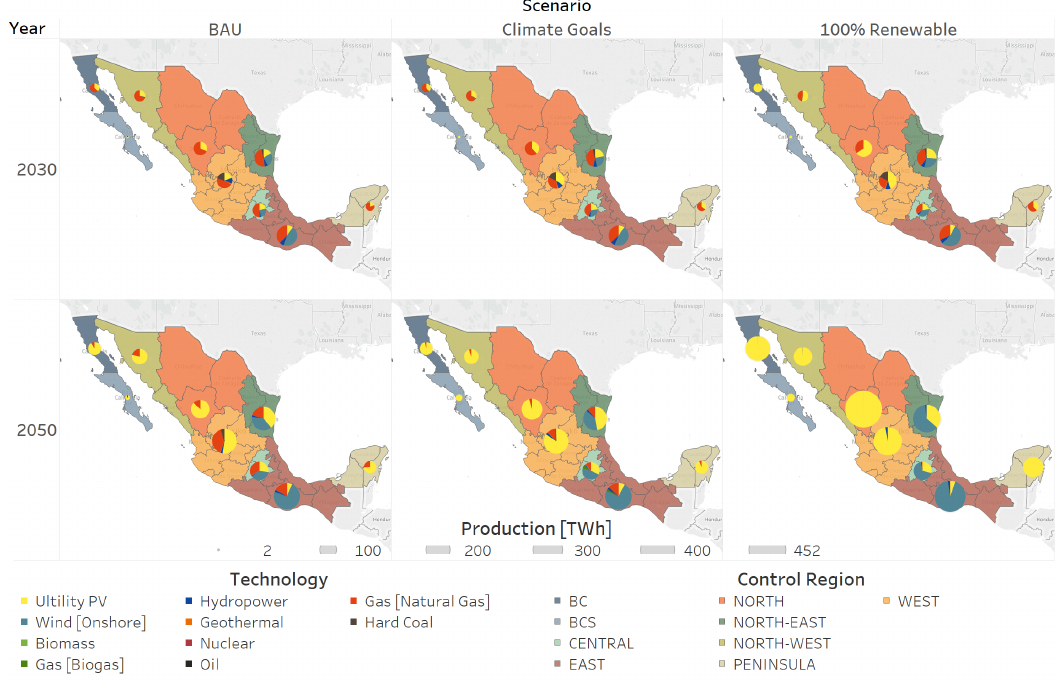
Figure 8. Regional generation of electricity in the years 2030 and 2050 per